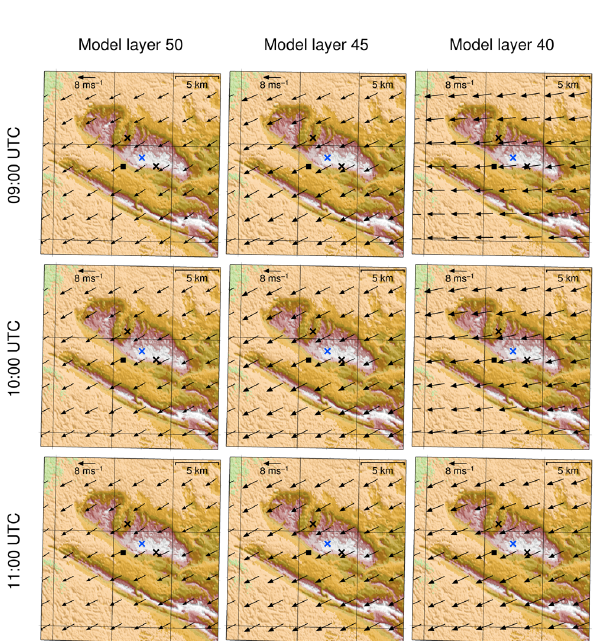
Fig. 5. Wind fields for different times (rows) and model layers (columns). Model layers 50, 45 and 40 thereby refer to altitudes above ground of approximately 10m, 256m and 824m, respec- tively, slightly depending on the surface elevation. Size of arrows is proportional to absolute wind speed.